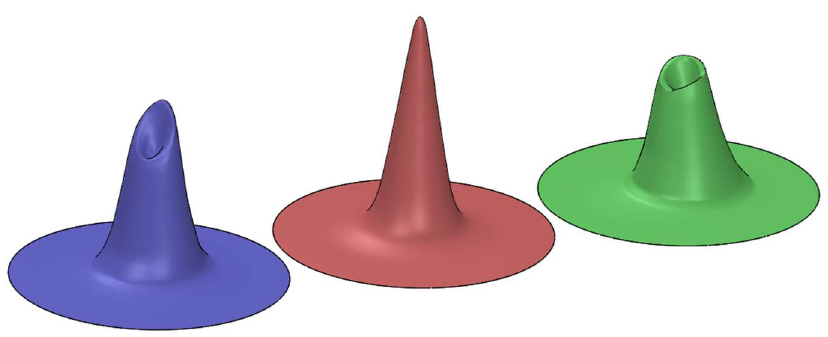
Figure 13. 3-D mapping of angular response for SQM 5009 ( left ), reconstructed manufacturer ( centre ), and SQM 5143 ( right ).